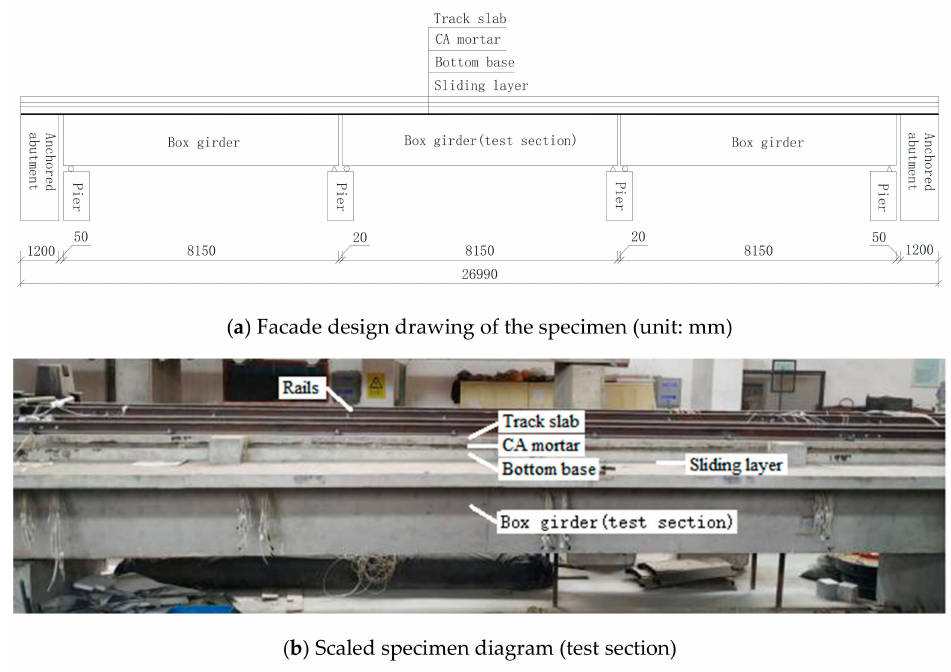
Figure 1. The scaled specimen of the high-speed railway (HSR) bridge with ballastless